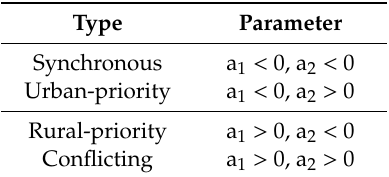
Table 2. The synergetic evolution classification of urban-rural complex